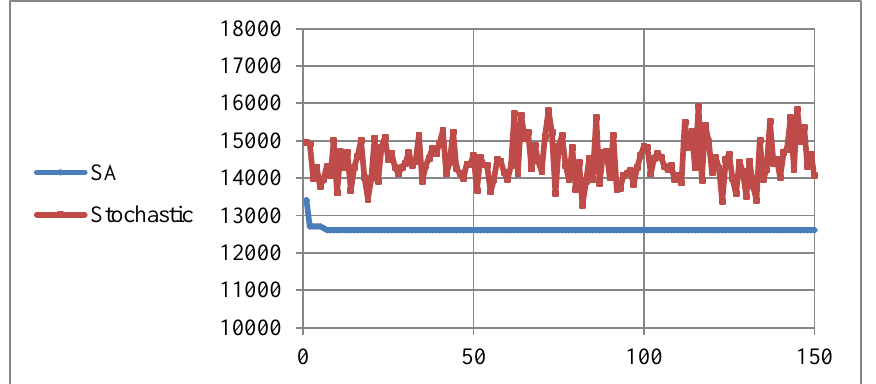
Figure 3. Comparison of convergence of SA with the totally stochastic algorithm of UA-CSLP case study (vertical axis: objective function value, horizontal axis: